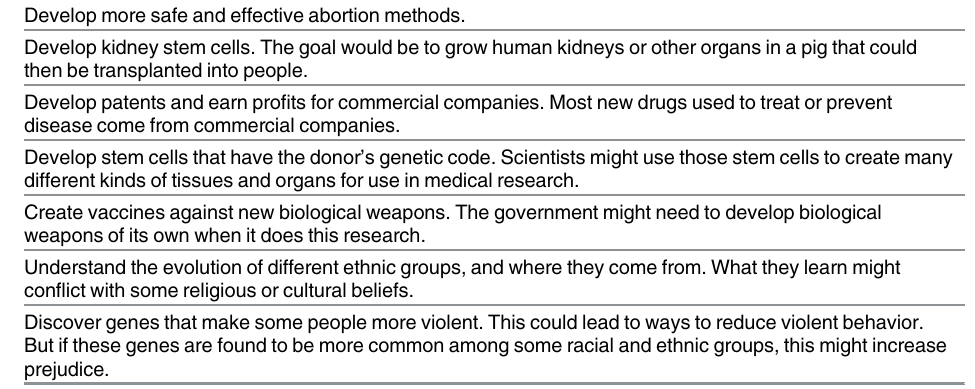
Table 1. Research scenarios that may provoke non-welfare interest (NWI) concerns. Develop more safe and effective abortion